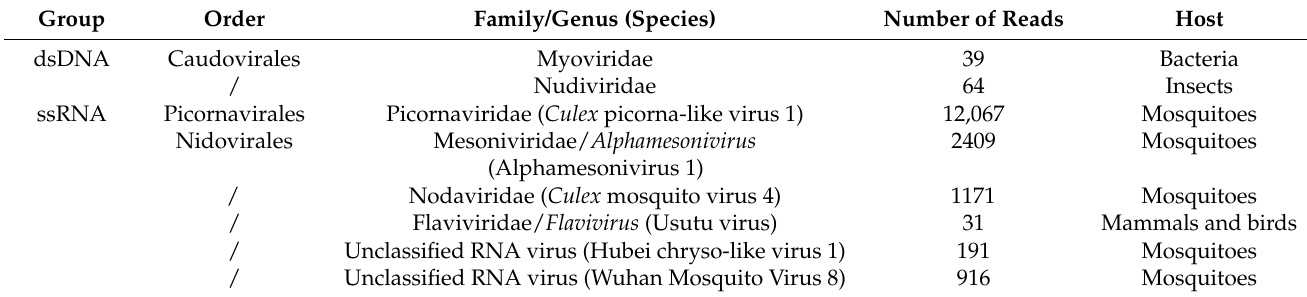
Table 4. Viruses detected by NGS in a Cx. pipiens complex mosquito pool sampled in Zagreb, 2018. Group